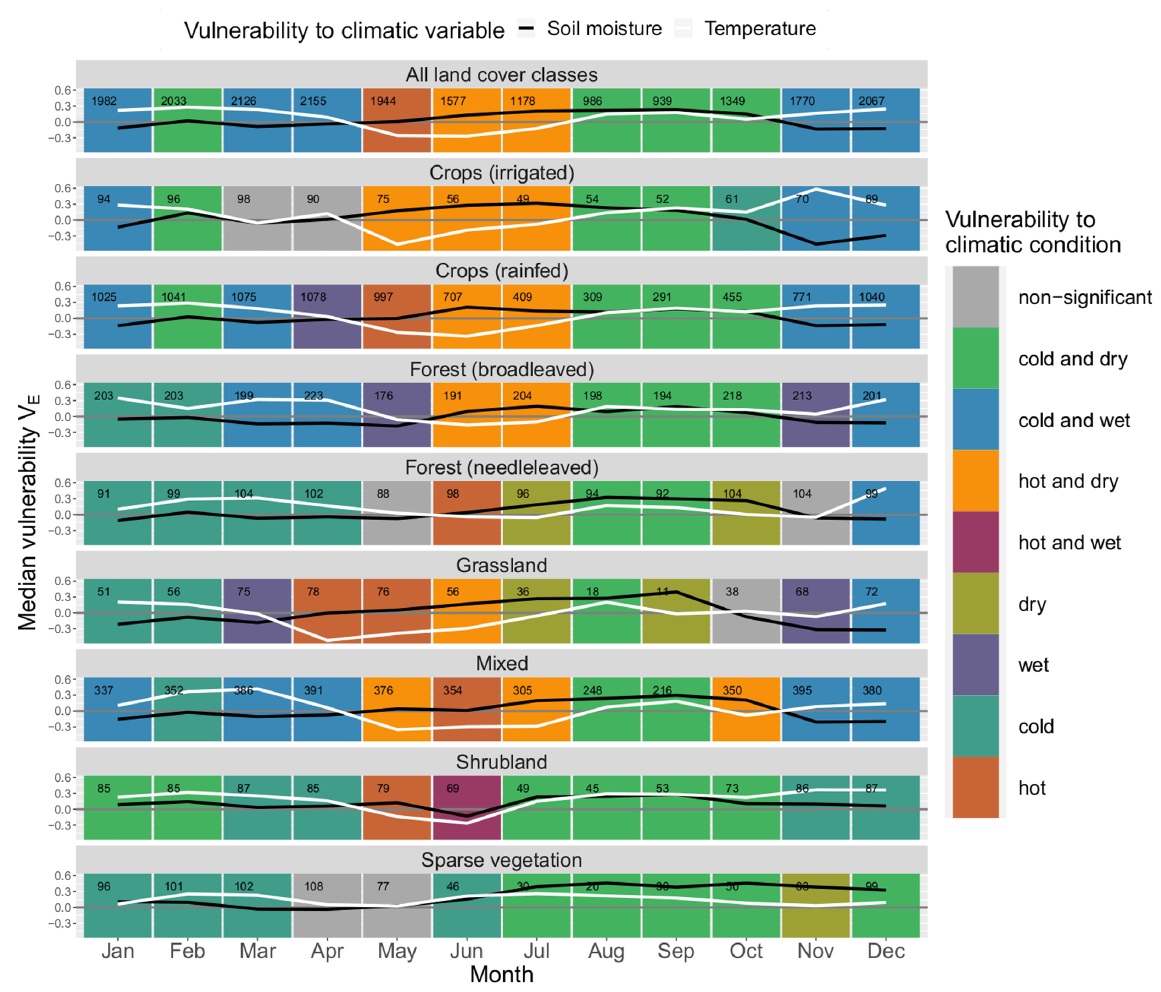
Figure 5. Median monthly ecosystem vulnerability per land cover: vulnerability to temperature (ERA5-Land) is shown in white, and vulnera- bility to soil moisture (ESA CCI) is shown in black for each month of the year (columns) for each land cover (rows). Months with statistically significant deviation in climatic drivers during non-hazardous and hazardous ecosystem conditions according to the Mann–Whitney U test based on a significance level α = 0 . 05 are shown in colour (see legend); all other months are shown in grey. The number of grid points in which an event has occurred in this month and land cover within the period 1999–2019 is shown in the upper left corner of each